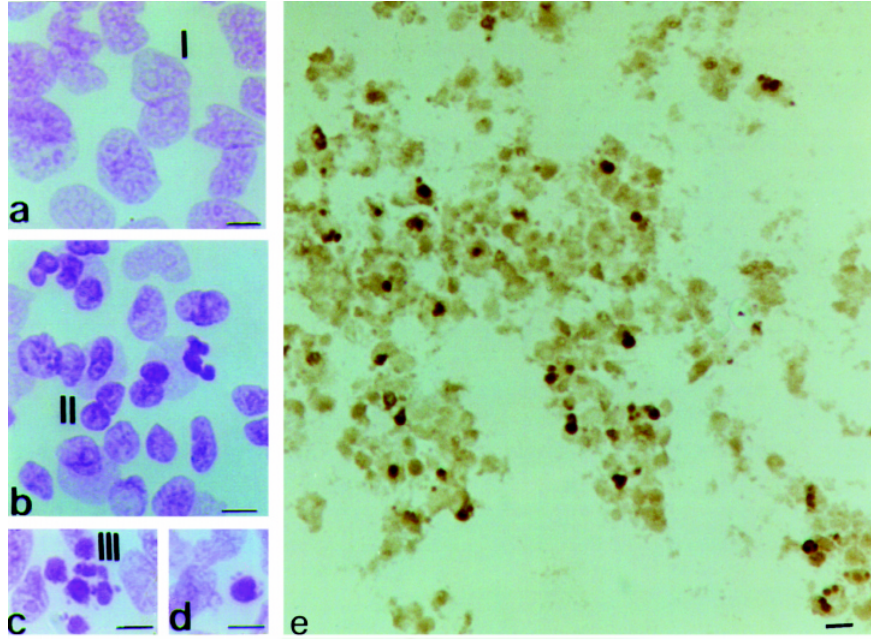
Figure 1 - Nuclear aspect of V79 fibroblasts after three days in culture. Different types of chromatin condensation are present in Feulgen-stained nuclei (a-d): I (control, a), II (suspected apoptosis, b), and III (apoptosis, c,d). The TUNEL assay confirmed occurrence of apoptosis in the cell population (e). Bar = 10 m